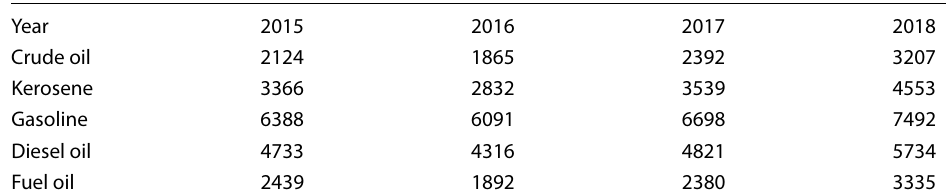
Table 5 The petroleum prices in 2015–2018 (unit: CNY/ tonne)